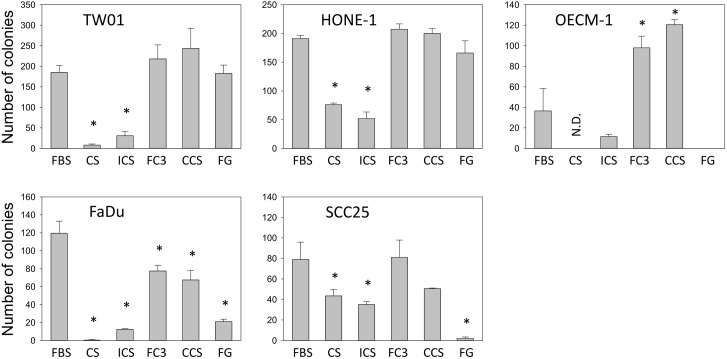
Plating efficiency of cells cultured in alternative sera.Plating efficiency was determined in cells cultured in fetal bovine serum (FBS), calf serum (CS), iron-supplemented calf serum (ICS), FetalClone III (FC3), Cosmic calf serum (CCS), and Fetalgro (FG) serum. Data indicate the average value of duplicates (mean ± SD). *:p<0.05 compared with cells cultured in FBS. N.D.: not determined because subculture terminated at P10 in OECM-1 cells.